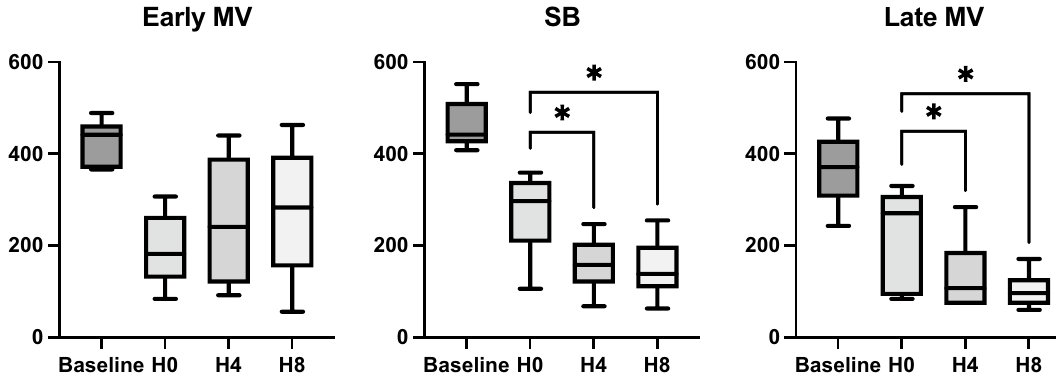
Figure 4. Changes in PaO 2 /FIO 2 over time in SB-group, Early MV group, and Late MV group. *p < 0.05, using GLMM for the SB-group, and the Friedman test for the Late VM